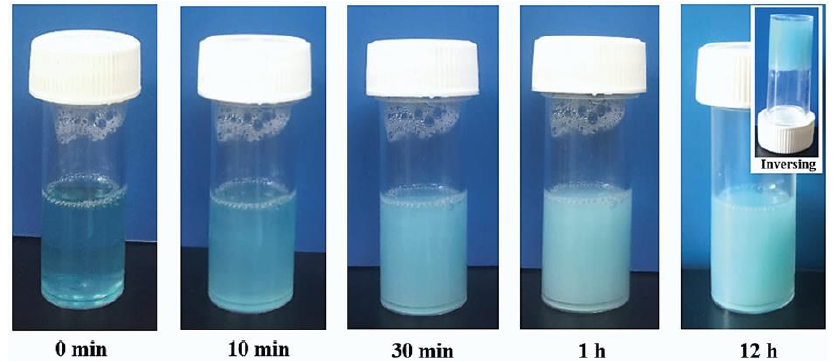
Figure 2. Evolution of the PHTrp-Cu hydrogel.